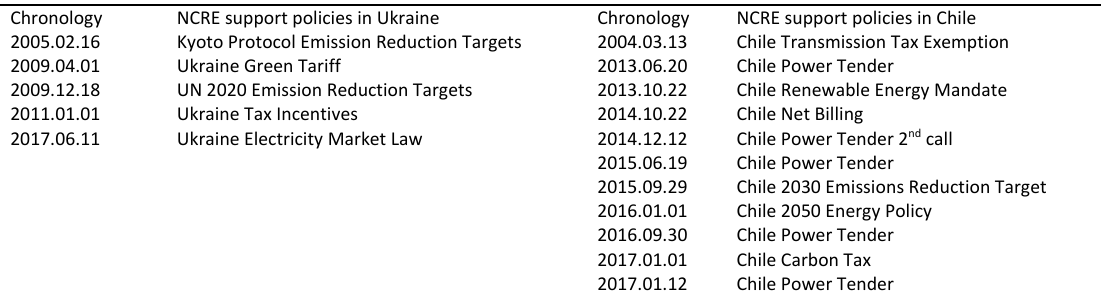
Table 5: Chronology of the main forms of national support in Ukraine and Chile 2004 vs 2017*